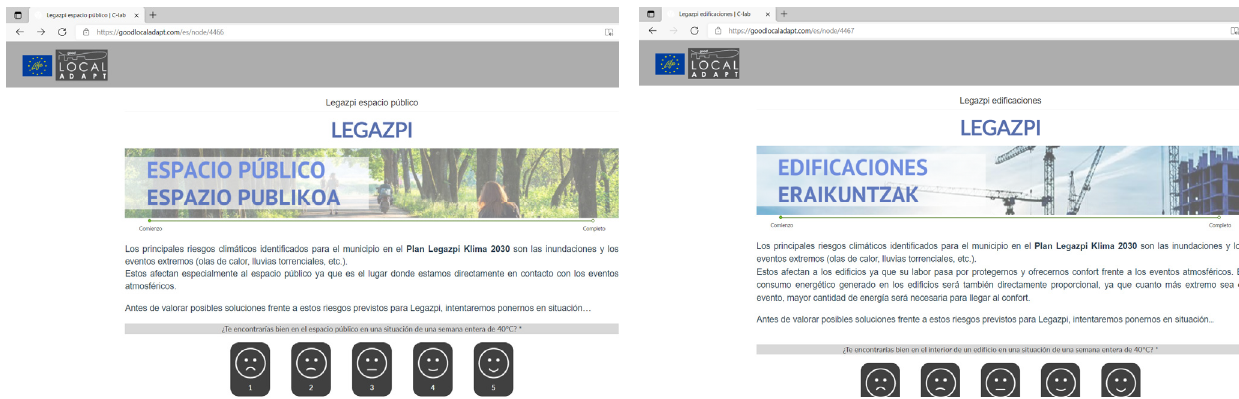
Figure 7. Screenshot of the consultation method of the on ‐ line platform of Legazpi.